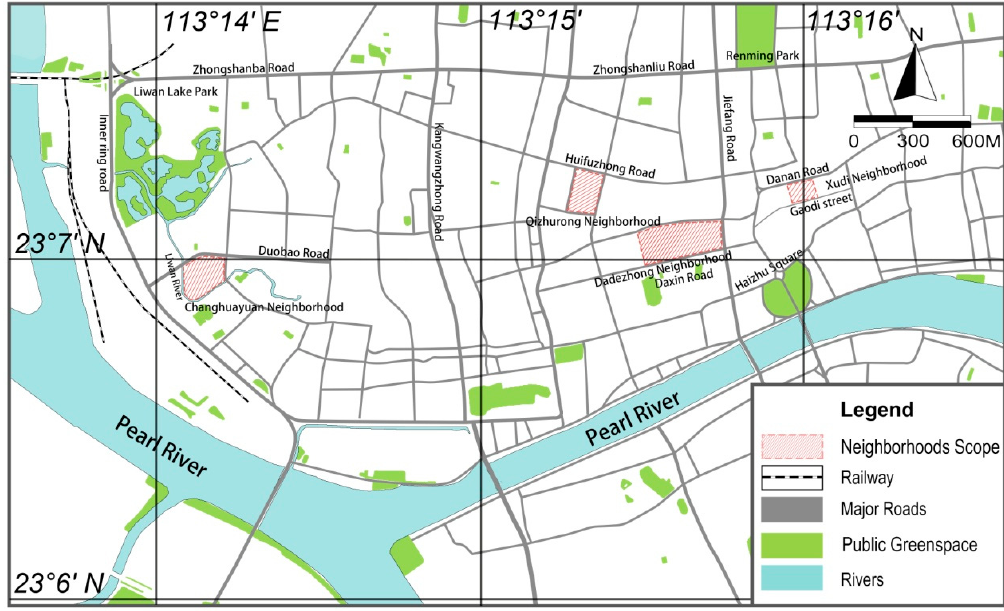
Figure 2. Distribution of the four survey areas in Guangzhou.